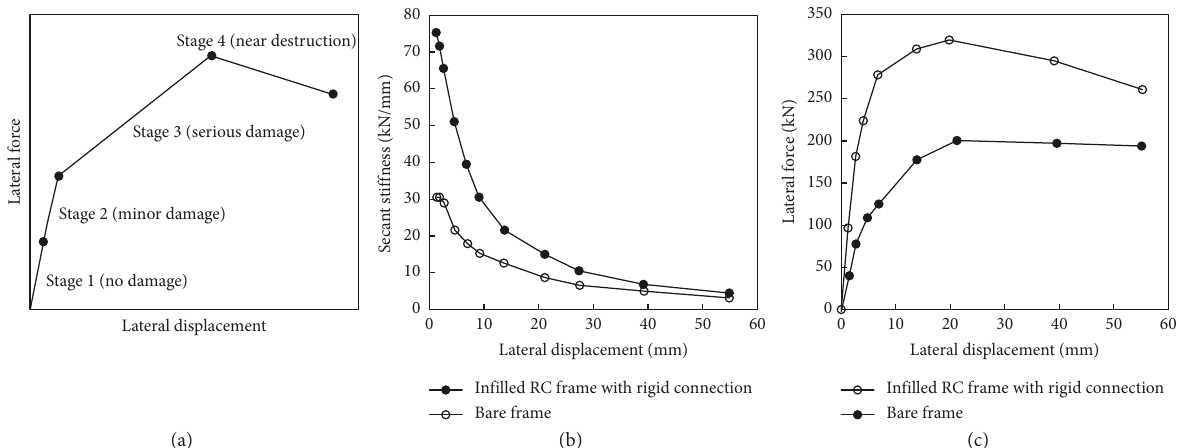
Figure 6: (a) Deformation failure processes; (b) stiffness degradation of two specimens provided by reference [38]; (c) deformation failure processes of two specimens provided by reference [38].